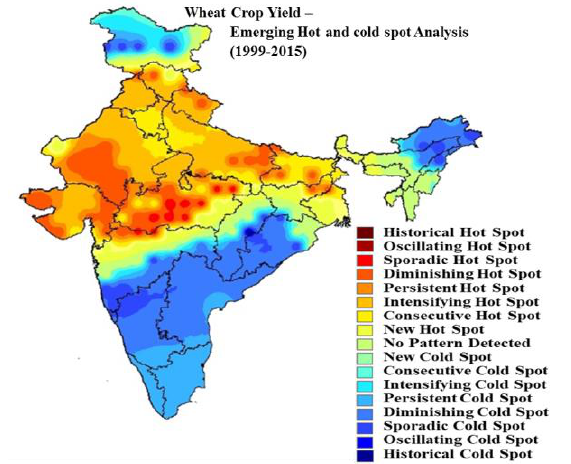
Figure 15 . Emerging hot and cold spot analysis of wheat crop yield